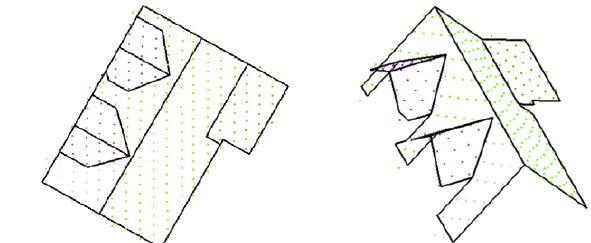
Figure 8. The resulting regularized building outline of our automatic reconstruction approach which is directly extracted from the BSP in top and perspective view.